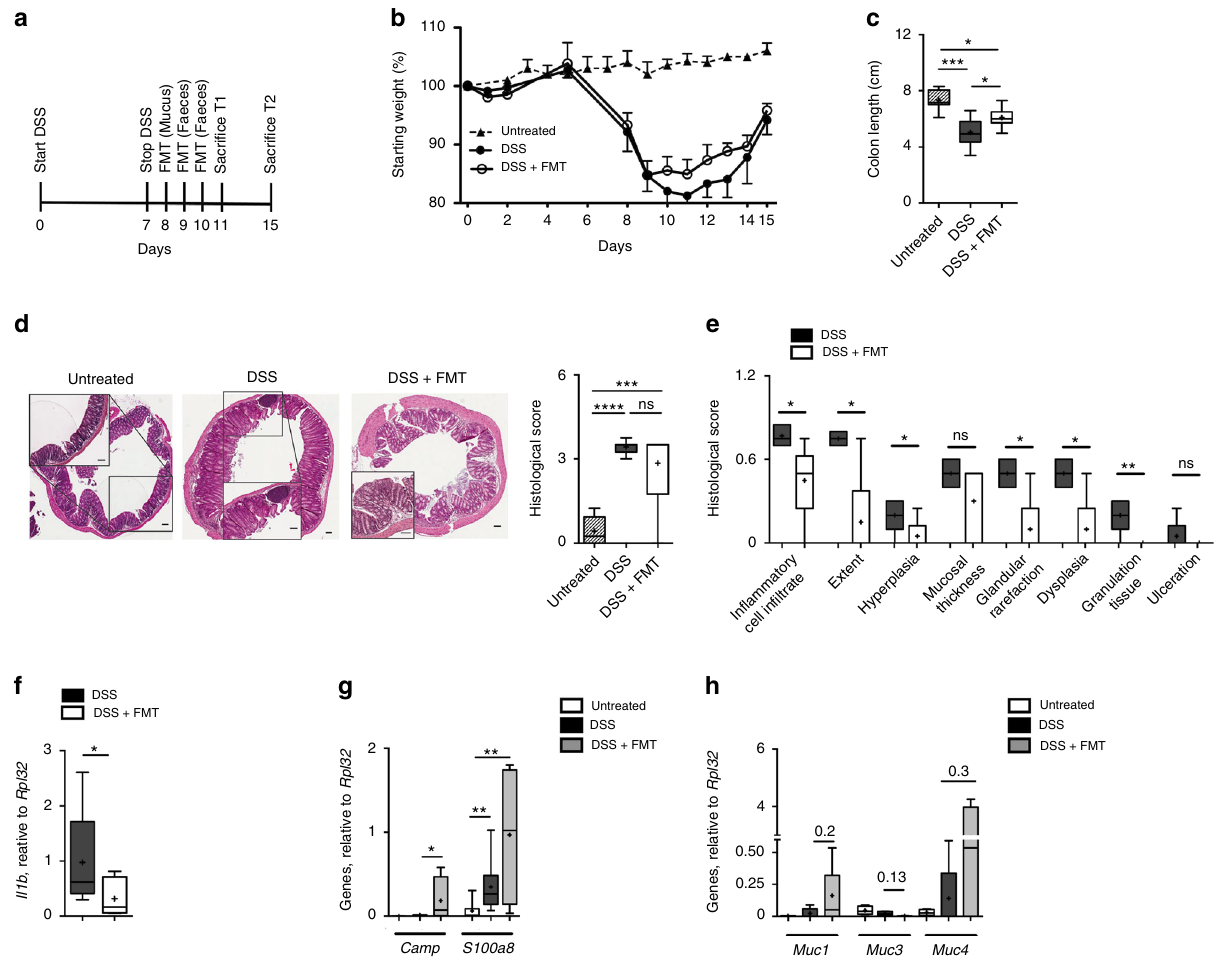
Fig. 1 Therapeutic FMT ameliorates DSS-induced experimental colitis. a Schematic representation of FMT treatment during acute DSS experimental colitis. b , c Weight loss ( b ) and colon length ( c ) of untreated (triangles and striped boxes), colitic (black dots and black boxes), or colitic mice treated with FMT (white dots and white boxes). d , e H&E staining (scalebar 100 µ m) and cumulative histological score of colon specimens obtained from DSS-treated and FMT-treated mice; ( e ) Detailed histological evaluation of mice with decreased histological score (white boxes) compared to DSS-treated mice (black boxes). f Colonic expression levels of Il1 β in colitic (black boxes) and FMT-treated (white bars) mice. g , h Colonic expression levels of Camp , S100A8 ( g ) and Muc1, Muc3, Muc4 ( h ) in untreated (white boxes), DSS treated (black boxes) or DSS + FMT-treated (gray boxes) mice. Statistical signi fi cance was calculated using a Mann – Whitney test for comparison within two groups or Kruskal – Wallis test with Dunn ’ s multiple comparison correction within more than two groups. * P < 0.05, ** P < 0.01, *** P < 0.001, **** P < 0.0001 were regarded as statistically signi fi cant. Outliers were detected with Grubb ’ s test. Non parametric distributions were represented as median + /- interquartile range. In Box and whiskers plots, centre line represents median; cross, represents mean. In ( b ) UT n = 10, DSS n = 10, DSS + FMT n = 10. In ( c ) UT n = 12, DSS n = 12, DSS + FMT n = 14. In ( d ) UT n = 8, DSS n = 15, DSS + FMT n = 19. In ( f – h ) UT n = 5, DSS n = 6, DSS + FMT n =